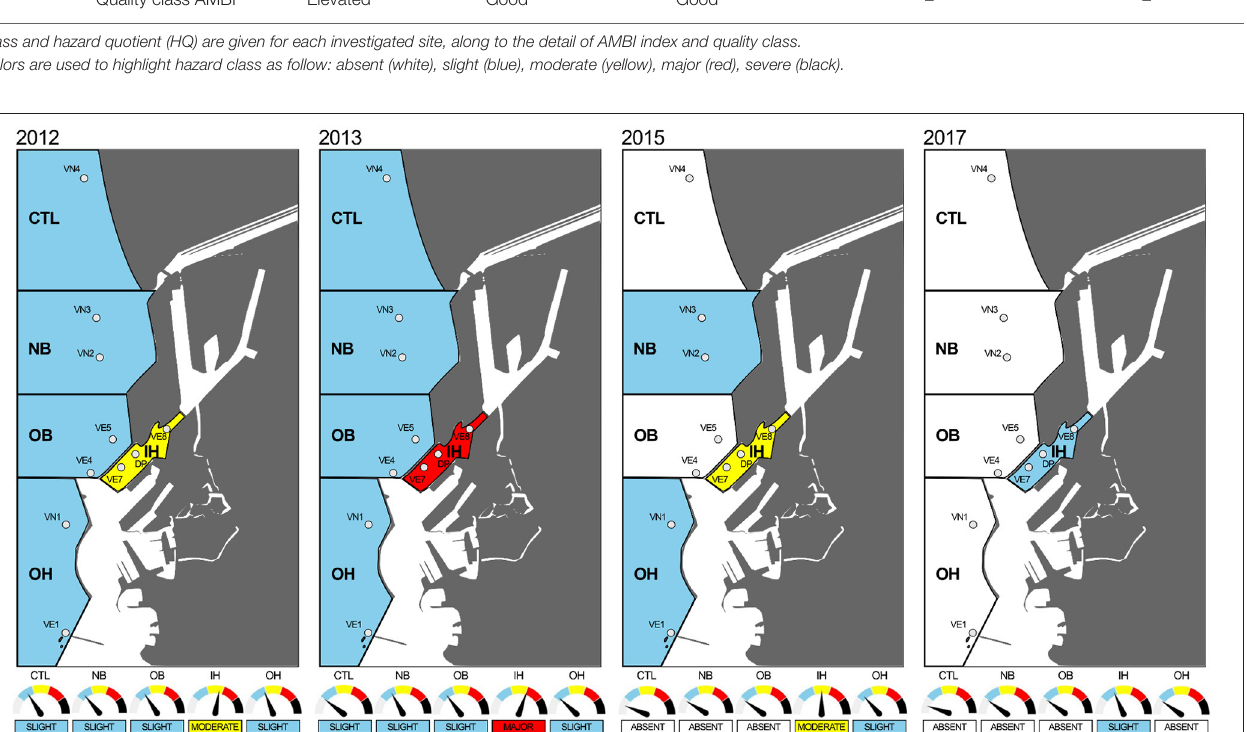
classification. In this study, a detailed evaluation of the chemical quality of sediments is obtained by using synthetic hazard indices based on the number, typology, and magnitude of chemicals exceeding specific thresholds (Regoli et al., 2019). Such an integrated approach allows easier comparison between